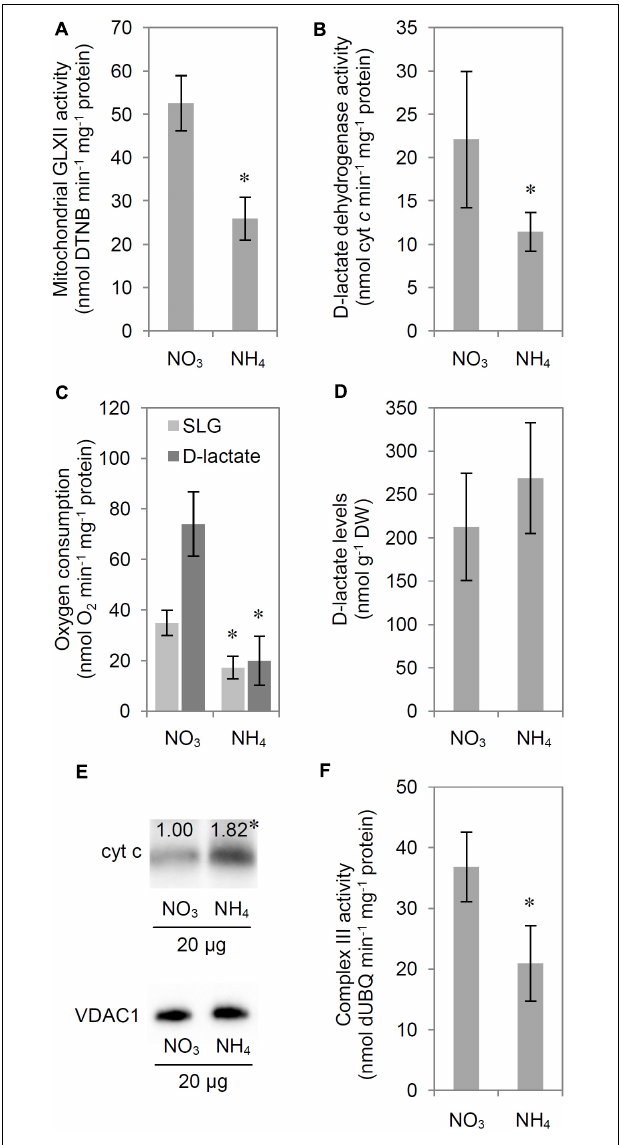
FIGURE 6 | Influence of ammonium (NH 4 + ) nutrition on S - D -lactoylglutathione (SLG) and D -lactate catabolism. Activity of (A) mitochondrial glyoxalase (GLX) II and (B) D -lactate dehydrogenase; (C) mitochondrial oxygen consumption with SLG or D -lactate as substrates; (D) D -lactate levels in leaf tissue; (E) cytochrome c protein levels in isolated and purified mitochondria and (F) activity of complex III of the electron transport chain in leaf tissue of nitrate (NO 3 − )-grown and NH 4 + -grown plants. Proteins from the mitochondrial fraction were resolved by tricine-sodium dodecyl sulfate-polyacrylamide gel electrophoresis, electroblotted on a polyvinylidene difluoride membrane, probed with a polyclonal antibody against cyt c , and visualized by chemiluminescence. Signal intensity, corresponding to cyt c (molecular mass, approximately 14 kDa) versus mitochondrial porin VDAC1 which was used for protein level normalization, was estimated using Quantity One 4.6.2 after background correction. Results are expressed relative to the control; the amount of protein in mitochondria isolated from the leaf tissue of NO 3 − -grown plants was set at 1.00. Representative results are shown. Values are the mean ± standard deviation (SD) of 3–5 biological and 1–3 technical replicates. Significant differences ( P ≤ 0.05) between NO 3 − -grown and NH 4 + -grown plants are indicated by an asterisk ( ∗